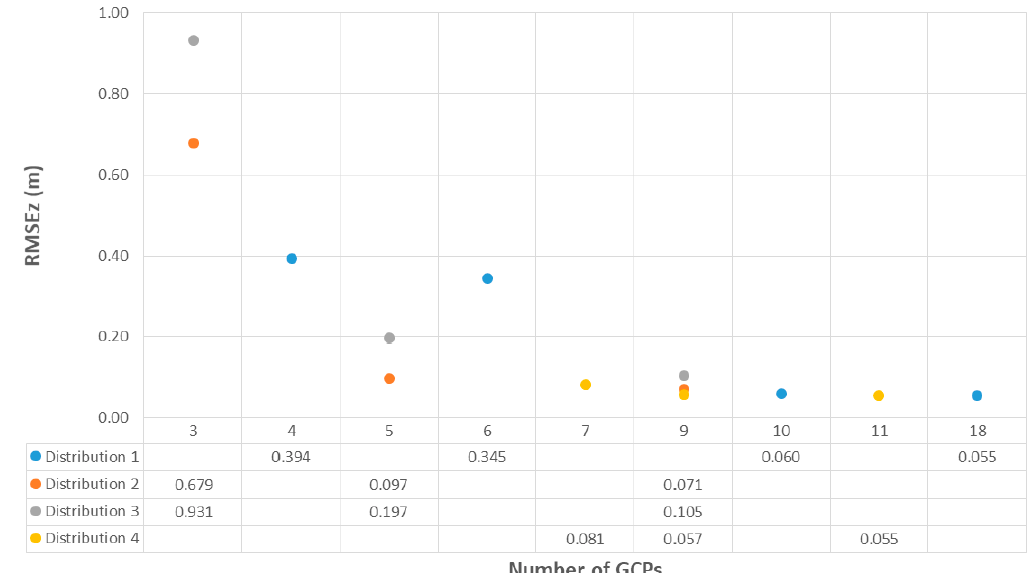
(Figure 10). RMSE z values ranged from 0.394 to 0.055 m for Distribution 1, from 0.679 to 0.071 m for Distribution 2, from 0.931 to 0.105 m for Distribution 3, and from 0.081 to 0.055 m for Distribution 4.